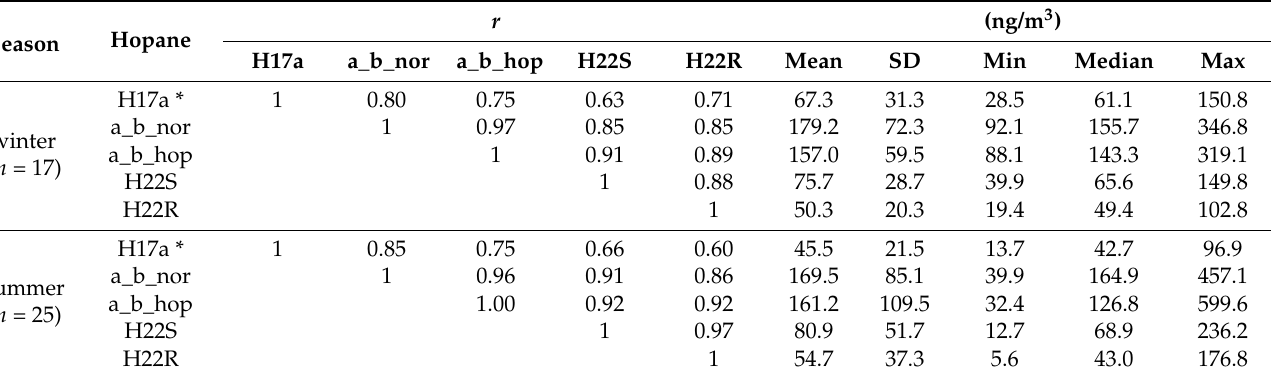
Table 4. Descriptive statistics and correlations of hopane species by